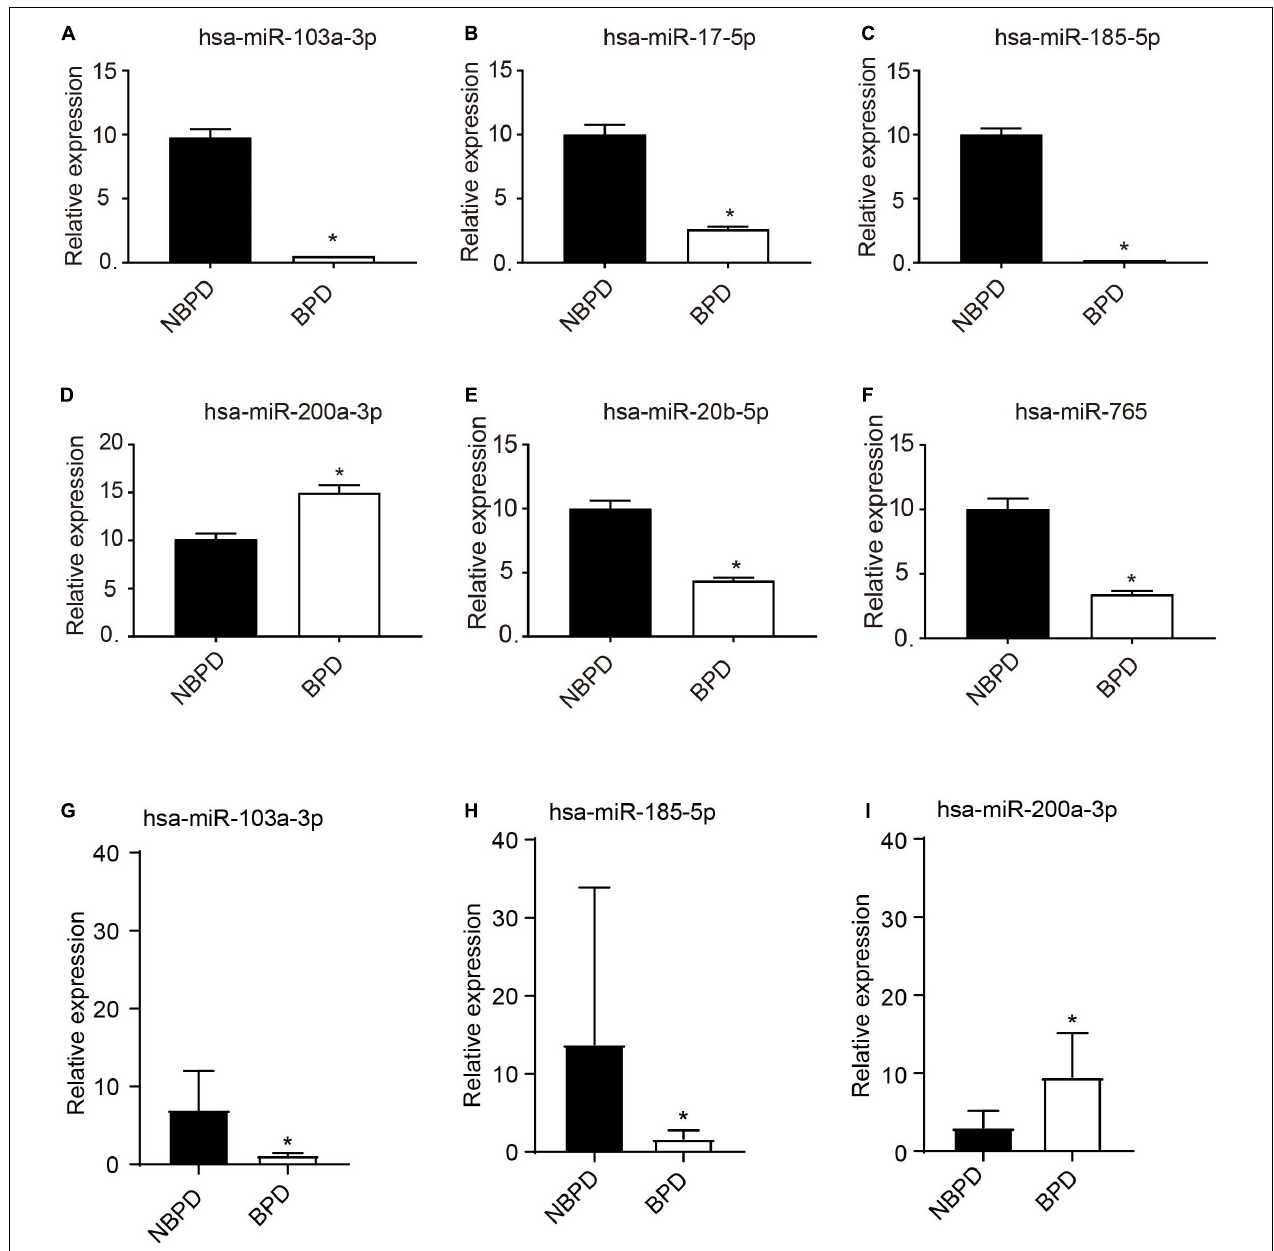
FIGURE 5 | Validation of expression of EXO-miRNAs by RT-qPCR. (A–F) Expression of 6 EXO-miRNAs was determined in the exosomes which were used for sequencing. n = 4. (G–I) Expressions of hsa-miR-103a-3p, hsa-miR-185-5p, and hsa-miR-200a-3p were further validated in an additional non-sequencing EXO-miRNAs samples from NBPD and BPD infants. n = 8. * P < 00.05, BPD versus